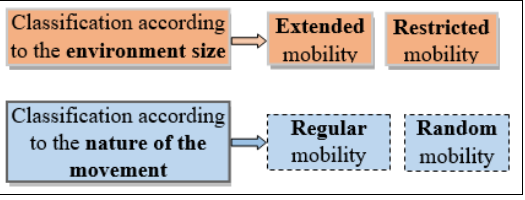
Figure 1 . Mobility